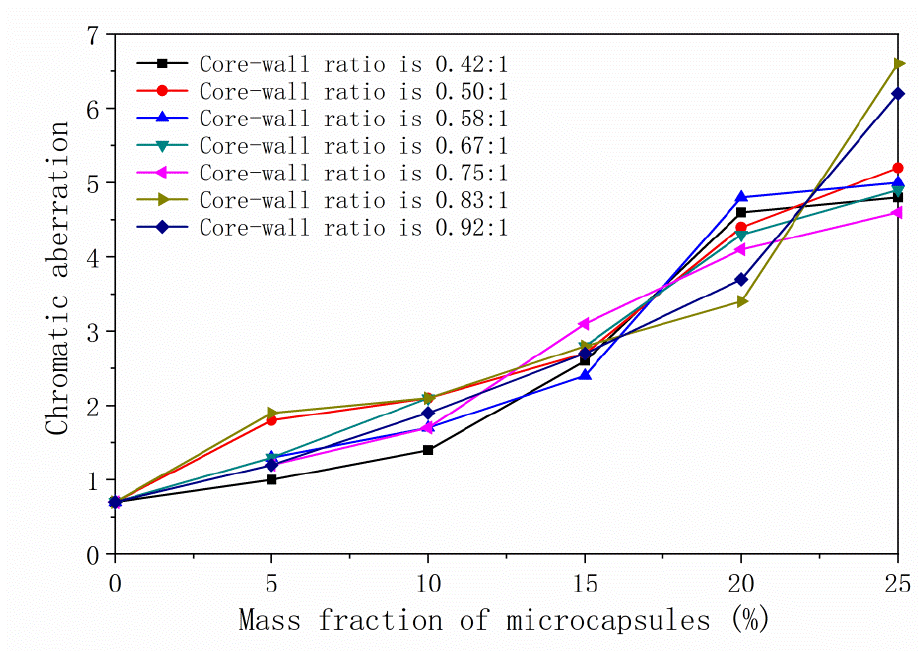
Figure 2. The chromatic aberration of the coatings.